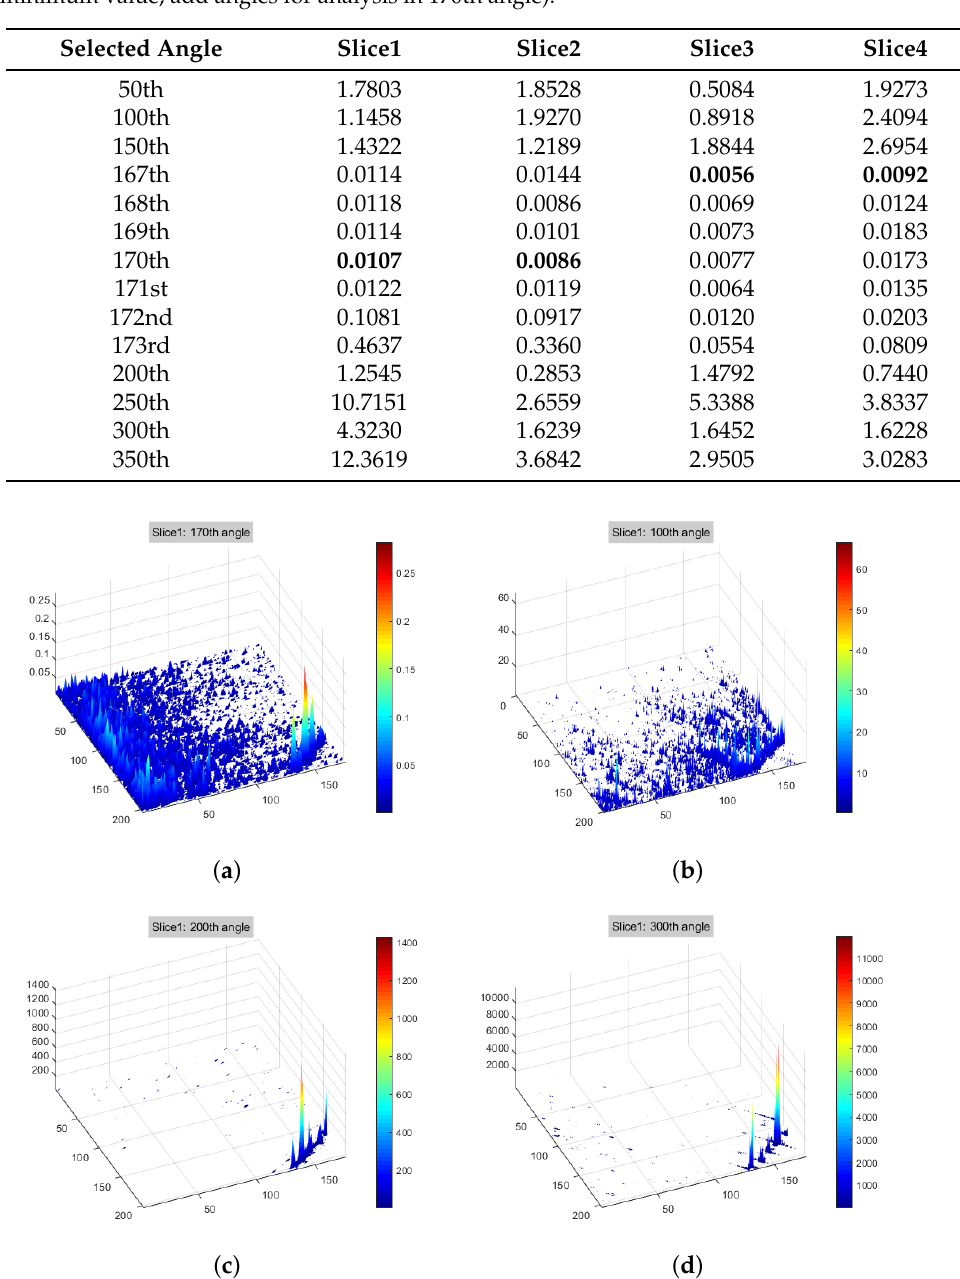
Table 4. σ parameter: four kinds of slices centered on the warehouse for 14 angles (Bold indicates the minimum value; add angles for analysis in 170th angle).